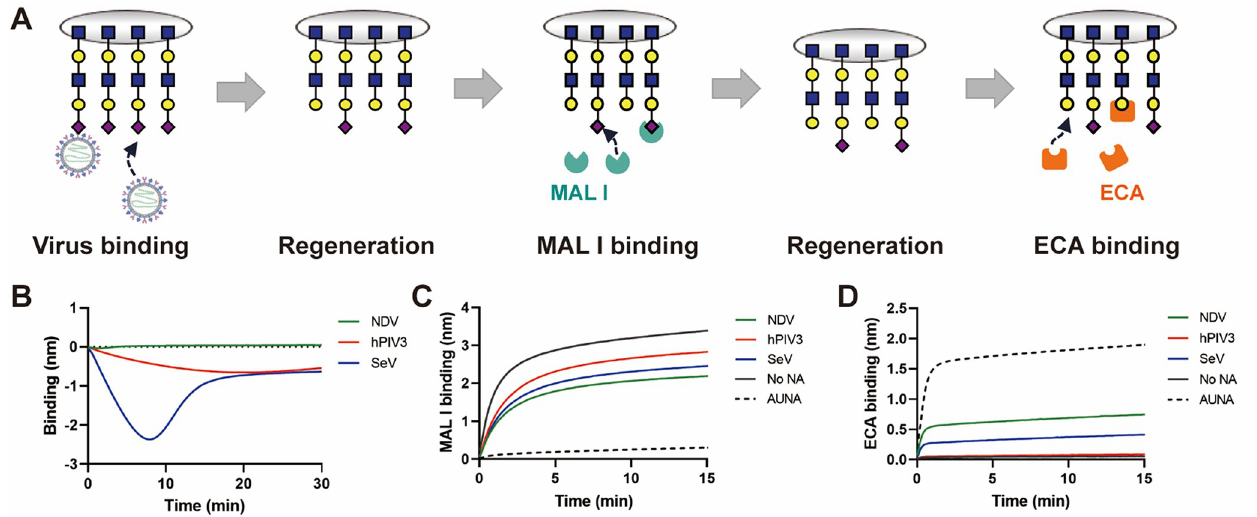
Fig 3. Analysis of NDV, hPIV3, and SeV binding and sialidase activity using lectin binding. ( A) Schematic representation of virus binding followed by the lectin binding assay. MAL I specifically binds to the remaining Neu5Ac α 2-3Gal β 1-4GlcNAc glycotope, while ECA prefers to bind the Gal β 1-4GlcNAc glycotope present after desialylation. (B) Virus binding curves were generated similarly as described in the legend to Fig 2 using 3’S(LN) 2 -PAA. (C) Binding of MAL I after incubation of the sensors with the indicated viruses. MAL I binding in the absence of NA activity (no NA) or after treatment of the sensors with Arthrobacter ureafaciensl NA (AUNA) is also shown. (D) Similar as for (C), but now using ECA. Low binding levels of MAL I and high binding levels of ECA correspond with high levels of desialylation.